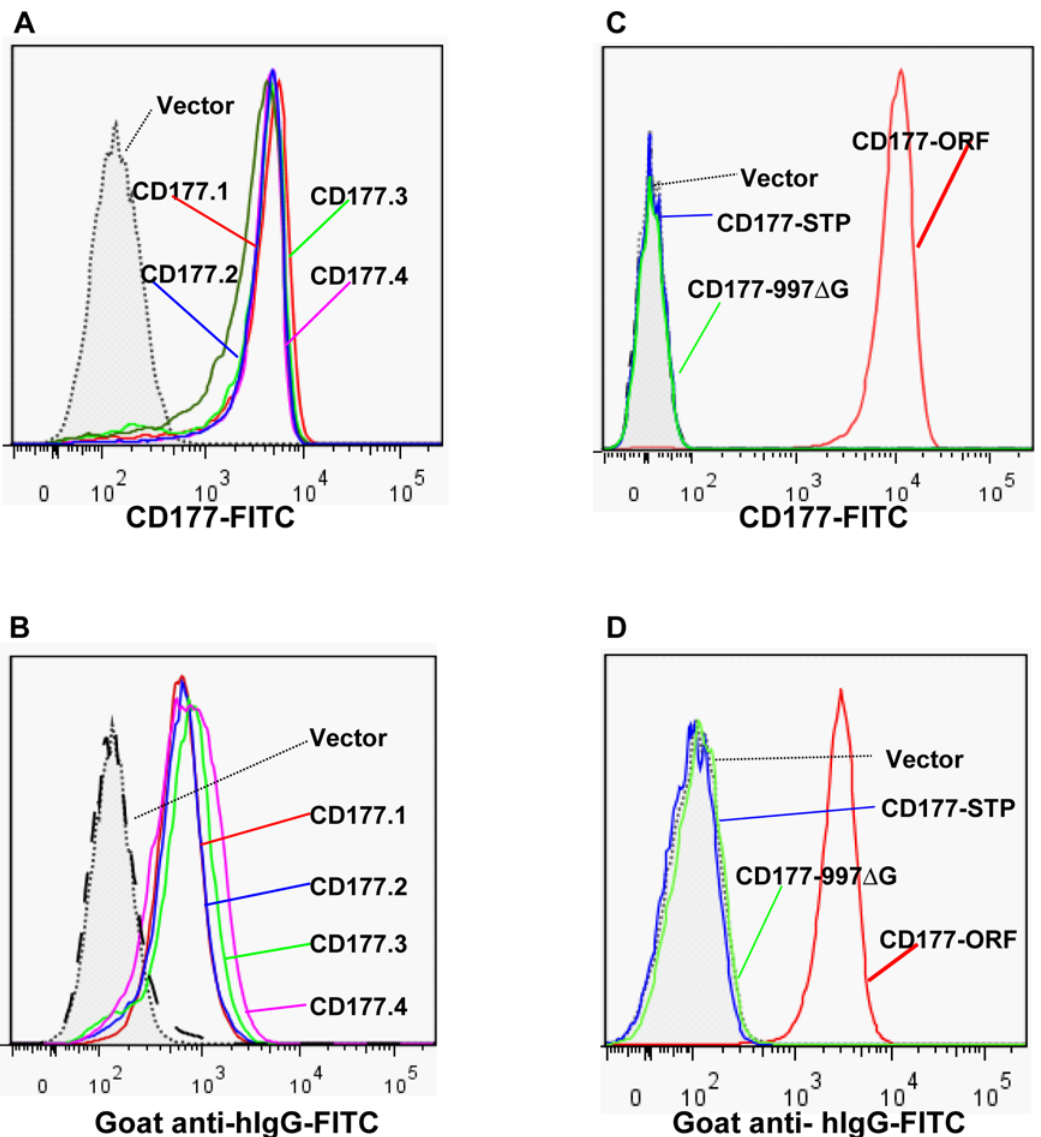
Fig 5. Effect of CD177 SNPs or mutation on HNA-2 expression and HNA-2 alloantibody binding. A). Expression of common CD177 SNP haplotypes or variants (CD177.1: 31L-204N-205R-348A. CD177.2: 31H-204N-205R-348A. CD177.3: 31L-204D-205M-348A. CD177.4: 31L-204N-205R-348T) on 293 cells. No significant differences of HNA-2 expressions were observed among four CD177 haplotypes consisting of four common non-synonymous cSNPs (SNP 134A > T, 652A > G, 656G > T, and 1084G > A), which encode the amino acid substitutions for 31His > Leu, 204Asn > Asp, 205Arg > Met, and 348Ala > Thr. B). No significant differences were observed in the HNA-2 alloantibody binding to four common CD177 variants (CD177.1: 31L-204N-205R-348A. CD177.2: 31H-204N-205R-348A. CD177.3: 31L-204D-205M-348A. CD177.4: 31L-204N-205R-348T). C). HNA-2 expression was absent in cells stably transfected with the CD177 expression constructs of the SNP 829T allele (CD177-STP) or 997G deletion mutation (CD177-997 Δ G). The SNP 829A allele (or CD177-ORF) serves as the positive control for HNA-2 expression. D ). Cells stably transfected with the expression constructs containing either SNP 829T (CD177-STP) allele or 997G deletion (CD177-997 Δ G) allele failed to react with HNA-2 alloantibodies. The SNP 829A allele (or CD177-ORF) serves as the positive control for HNA-2/CD177 expression. All experiments were repeated at least three